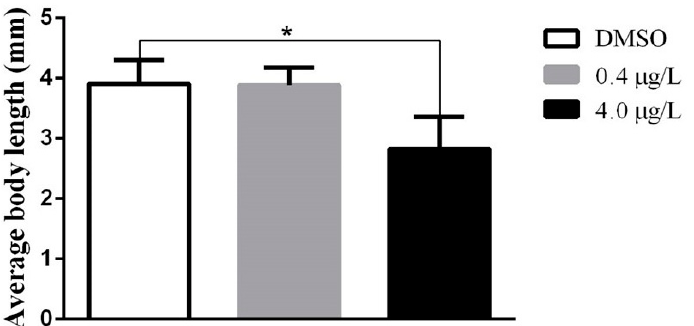
Figure 3. Bar graph showing the average body length at 144 hpf. Results are presented as mean ± standard deviation ( n = 3). Unpaired Student’s t-tests were performed to assess significance. * statistically significant ( p < 0.05).